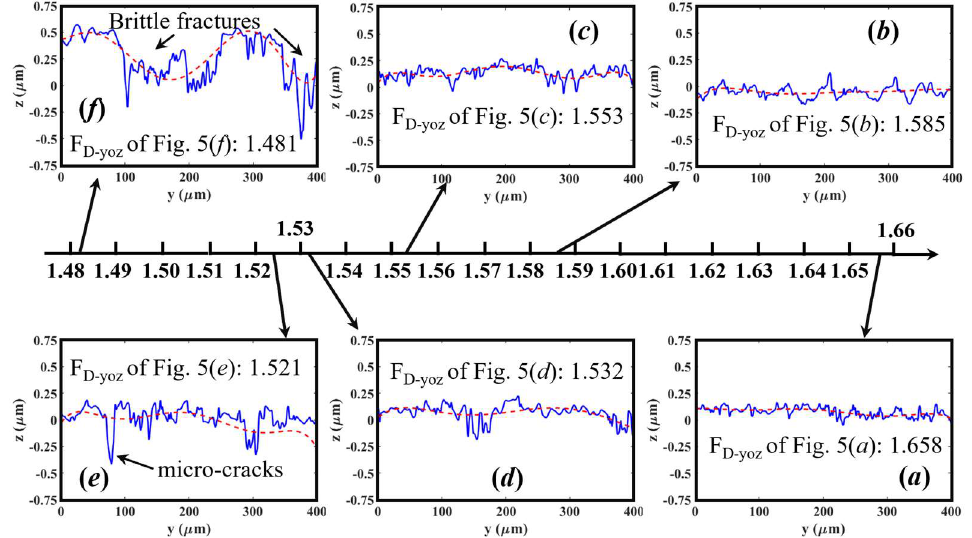
Figure 11. The cross-sectional contours of KDP surfaces shown in Figure 5 parallel with the feed direction and the corresponding 2D fractal dimension ( F D ). The red dash lines are the fitted curves through cubic